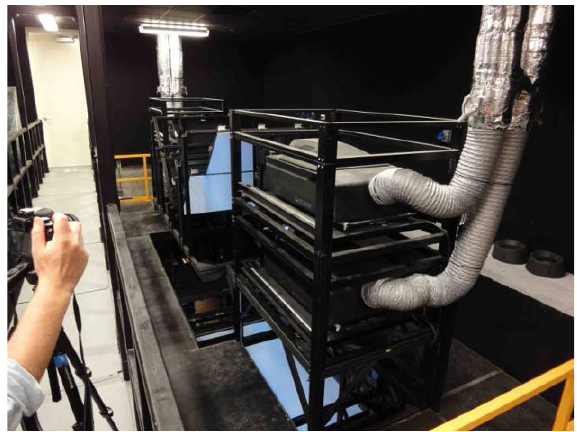
Figure 8. Cornea upper projectors. Photo: Greg